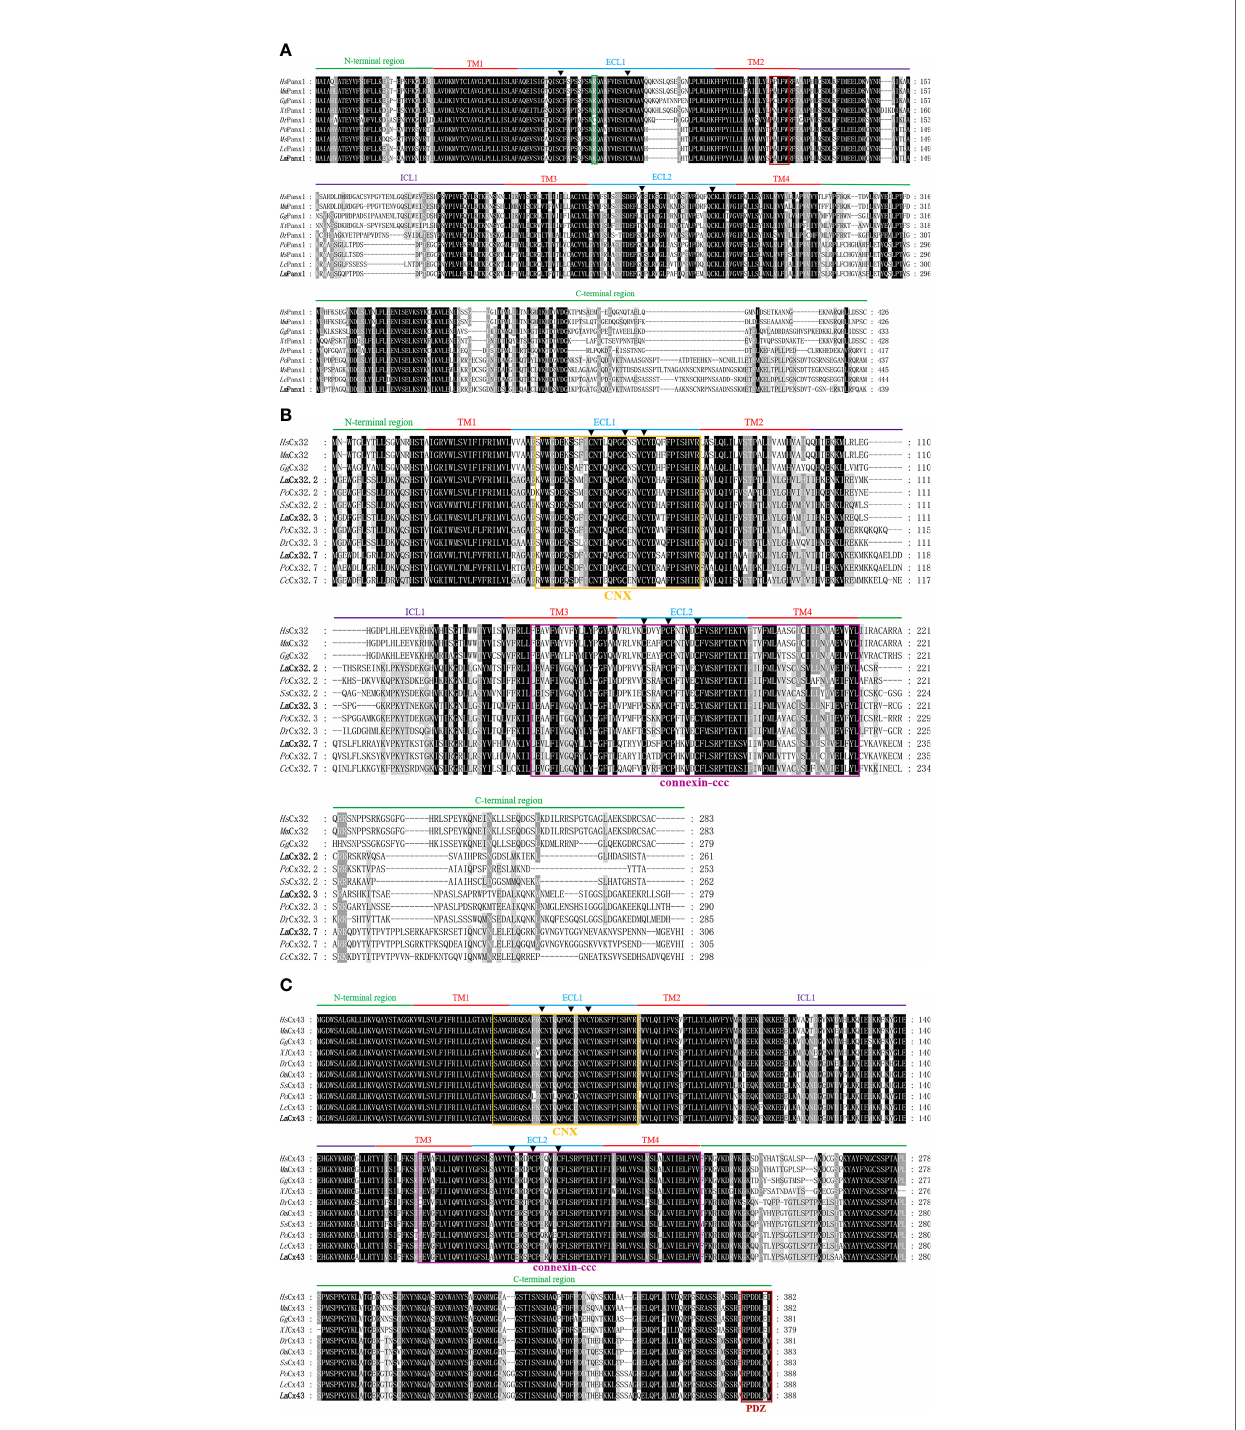
FIGURE 1 | Multiple sequence alignment analysis of Panx1 (A) , Cx32 (B) , and Cx43 (C) . The N-terminal region, four TM domains (TM1-4), the intracellular loop (ICL1), the extracellular loops (ECL1-2), and the C-terminal region of Lm Panx1, Lm Cx32, and Lm Cx43, are marked above the alignment. Symbol ( ▲ ) indicates the conserved cysteine residues. The K or R residue in position 75 and the classic innexin-speci fi c P-X-X-X-W motif are boxed in green and red, respectively. In addition, the CNX domain, connexin-ccc domain, and PDZ domain are boxed in yellow, purple, and red, respectively. The Lm Panx1, Lm Cx32, and Lm Cx43 are shown in bold. The accession numbers of sequences are shown in Figure 2 . Hs , Homo sapiens ; Mm , Mus musculus ; Gg , Gallus gallus ; Xt , Xenopus tropicalis ; Dr , Danio rerio ; Po , Paralichthys olivaceus ; Ms , Morone saxatilis ; Lc , Larimichthys crocea ; Lm , Lateolabrax maculatus ; Ss , Salmo salar ; Cc , Cyprinus carpio ; Om , Oncorhynchus mykiss